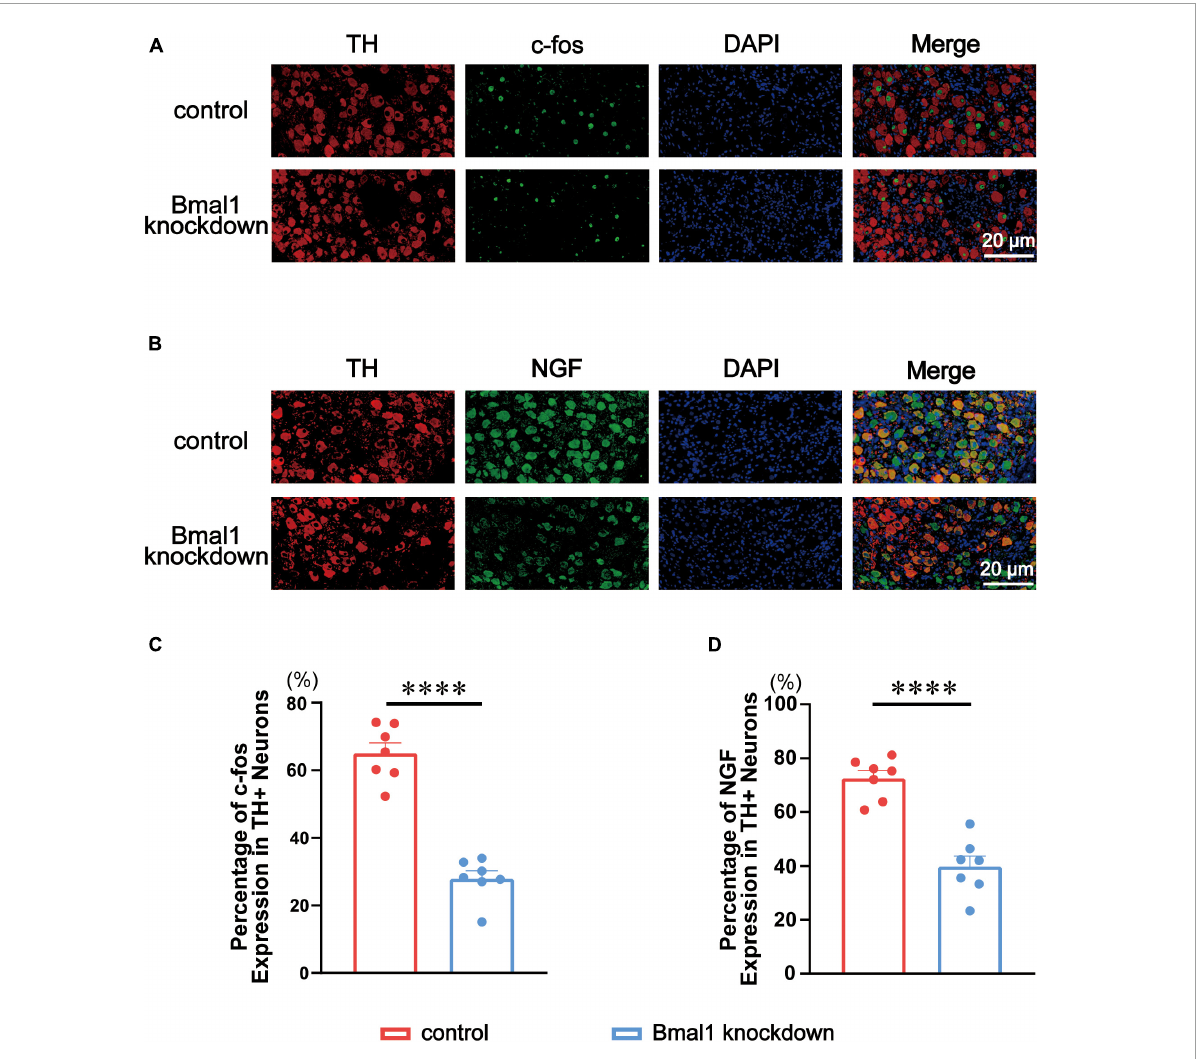
FIGURE4 Effects of Bmal1 knockdown on c-fos/NGF expression in the LSG. (A,B) Representative immunofluorescent co-staining for c-fos/NGF with TH in the LSG in both groups. (C,D) Quantitative analysis of c-fos/NGF expressed as the percentage of TH + neurons. n = 7 for each group. ∗∗∗ p < 0.001. ∗∗∗∗ p < 0.0001. LSG, left stellate ganglion; NGF, nerve growth factor; TH, tyrosine